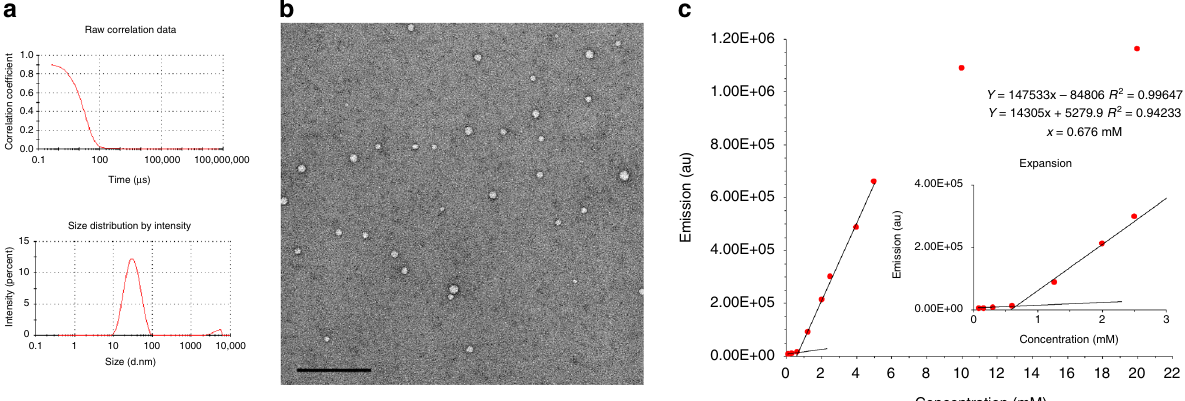
Fig. 3 Characterisation of self-assembled amphiphile 3a . a DLS shows good correlation with an average size particle of 28 nm. b TEM image showing particles with an average diameter of 27 nm (scale bar of 200 nm). c Emission vs. concentration and CMC